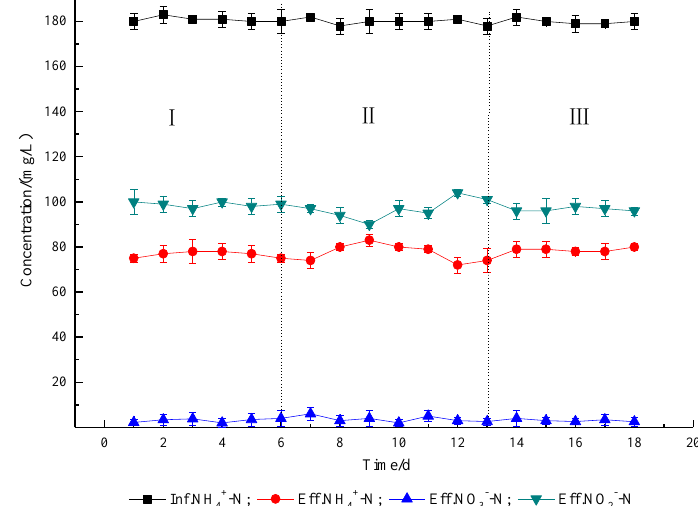
Figure 2. Nitrogen relationship between influent and effluent during the partial nitrification stage; Stages I, II, and III indicate that HRT is 14, 10, and 6 h, respectively.